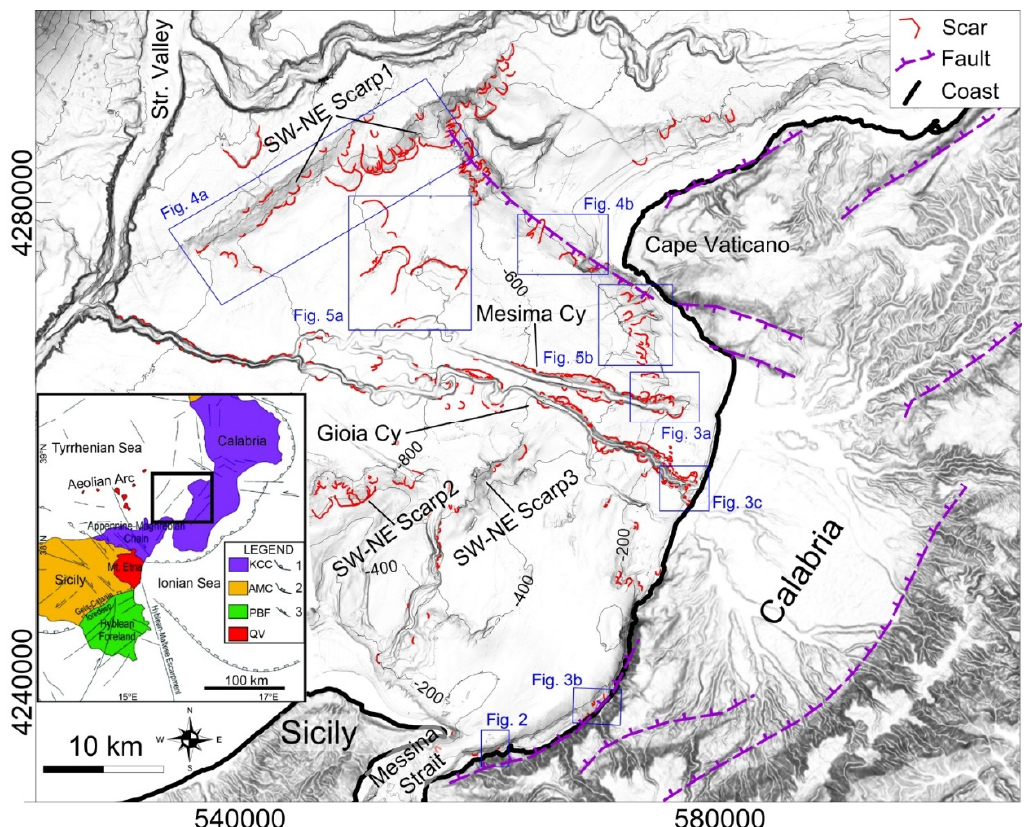
Figure 1. Shaded relief map (azimuthal light) of the Calabro–Tyrrhenian continental margin encompassed between Cape Vaticano and the Messina Strait (location in the inset), with the indication of the recognized landslide scars (red lines from [15]), the main faults (violet lines from [16]) and the location of the following figures (blue boxes). The inset shows a simplified structural sketch of Southern Italy (modified from [17]); KCC: Kabilo–Calabride Chain Units; AMC: Appennine–Maghrebian Chain Units; PBF: Pelagian Block Foreland Units; QV: Quaternary Volcanoes; 1 regional overthrust of the Kabilo–Calabride units upon the Apennine–Maghrebian; 2 external front of the Apennine–Maghrebian Chain upon the Foreland units and the External Thrust System Chain; 3 main normal and strike–slip faults.